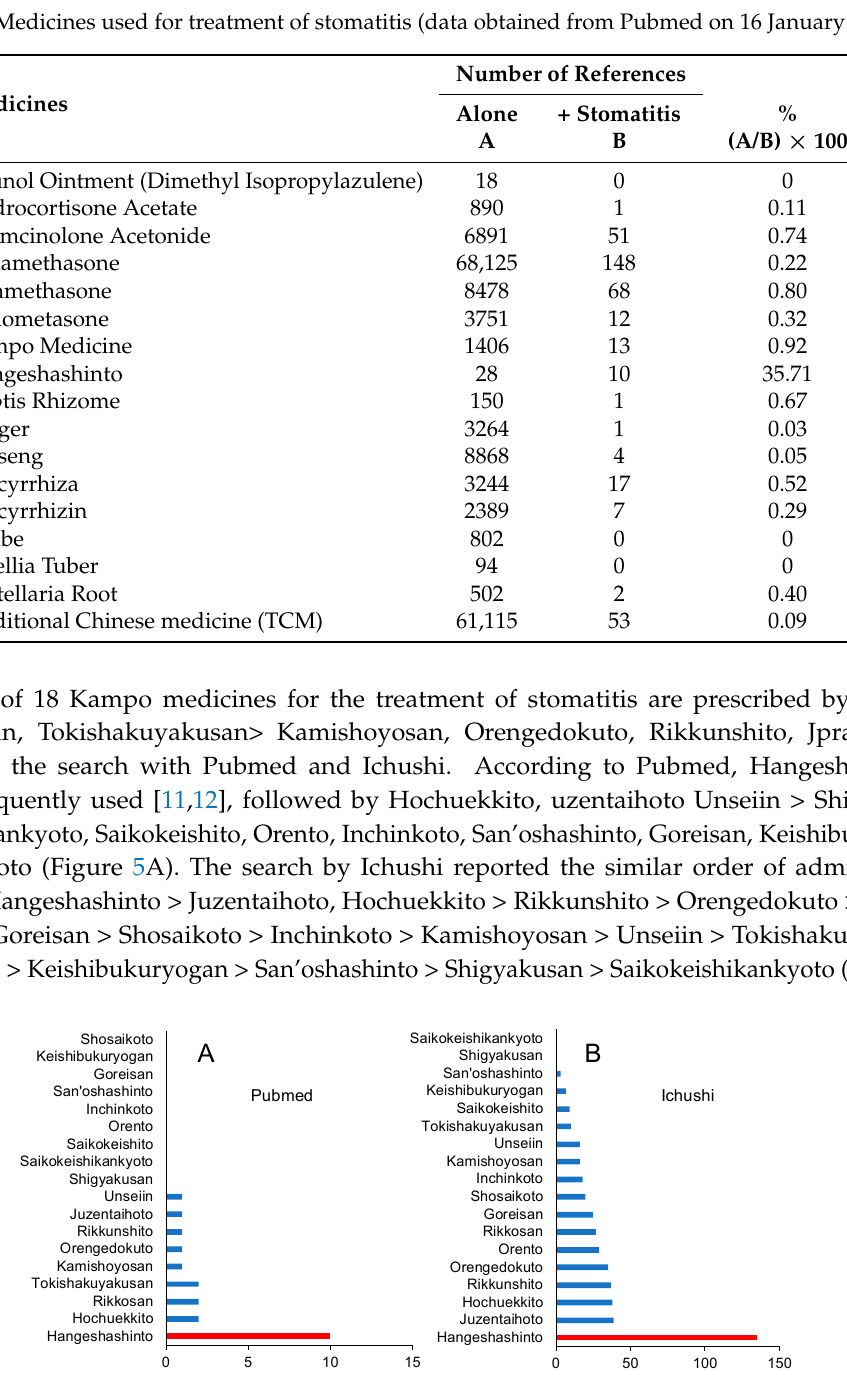
Number of papers cited Figure 5. Hangeshashinto is the most popular kampo medicine for the treatment of stomatitis. Data obtained from Pubmed on 16 January 16 2019. ( A ): Data from pubmed; ( B ): Data from Ichushi. Goreisan, known as “hydrostatic modulator” for edema, diarrhea, headache, nausea, and dizziness [13] is used to treat dry mouth. Rikkosan, a negative regulator of IL-1 β network [14], plays a supplementary role for stomatitis by relieving the pain. Kamishoyosan (KSS), that enhances peripheral circulation and reduces stress and associated pain [15], and saikokeishikankyoto, that reduces posttraumatic stress [16], are effective to refractory and recurrent